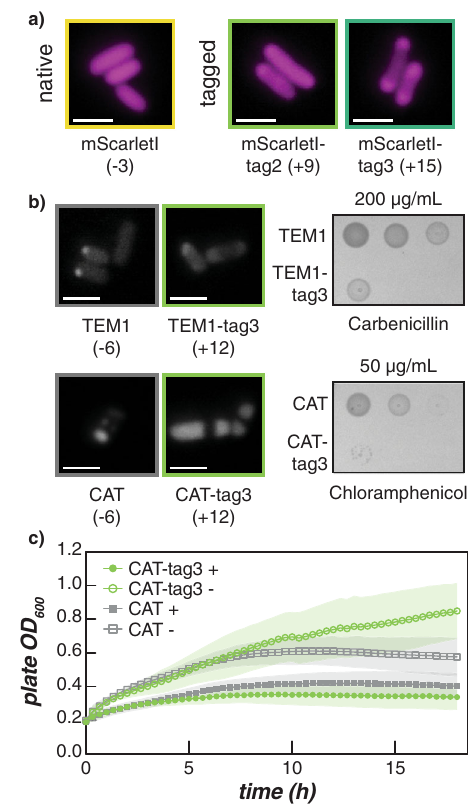
Fig. 5 | Cationic tags induce intracellular phase separation of proteins of interest. a Microscopy images of mScarletI and tagged variants at 24h post- induction. b Microscopy images of β -lactamase (TEM1), chloramphenicol acetyl- transferase (CAT), and tagged derivatives at 24h post-induction. Each protein containedanN-terminaltetracysteinetagfor fl uorescencestaining(left).Scalebars on all micrographs are 2 µ m. Spotting assay on LB plates supplemented with the respective antibiotic indicate that the presence of the cationic tag does not com- pletely inhibit growth (right). Reduced fi tness of the tagged relative to the untag- ged strains was also observed on control plates with no antibiotic (Supplementary Fig.26). c The growth of CAT(squares) and CAT-tag3 (circles) inliquidculturewas monitored in the presence (+; fi lled symbols) or absence ( − ; open symbols) of chloramphenicol.Treatmentwithantibioticresultedinmodestgrowthdefects,but no differences wereobserved between the CATvariants. Data points represent the average of fi ve biological replicates and shaded regions show the standard